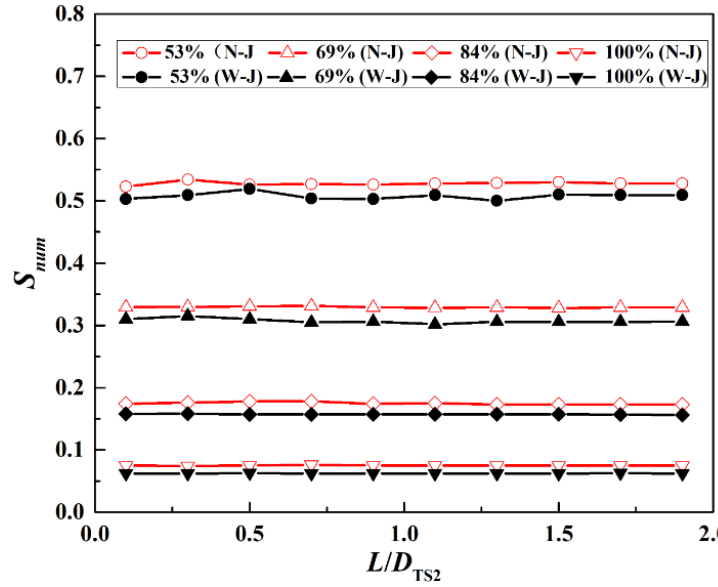
Figure 10. The swirl intensity S num under four operating conditions.